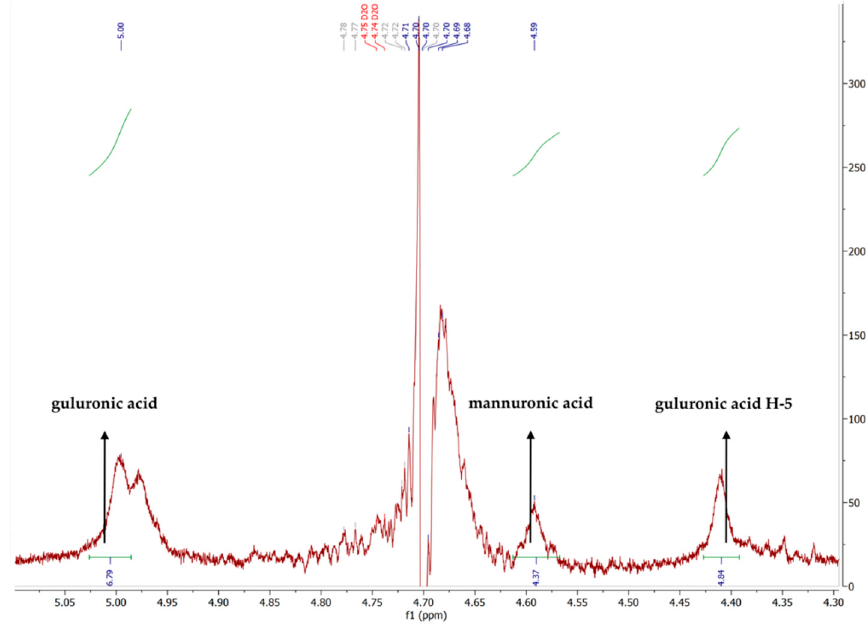
Figure 1. A fragment of the 1 H NMR spectra of sodium alginate Protanal LF 10/60 LS.